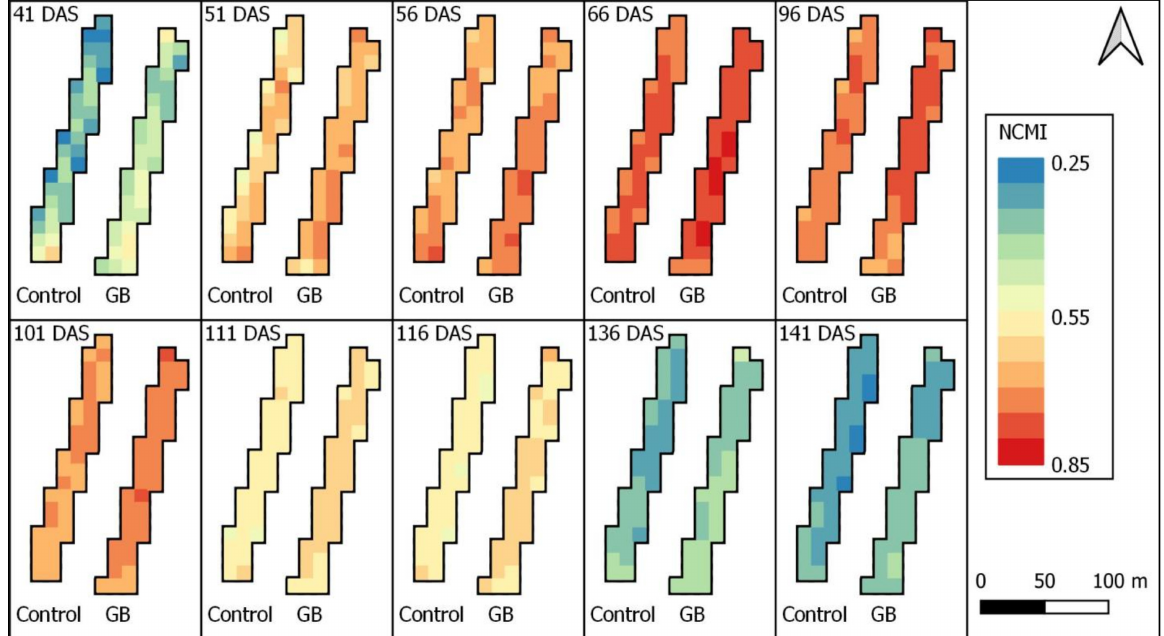
Figure 9. Spatial distribution of NCMI values at 10 m spatial resolution for each date analyzed. Arrow indicate the proper